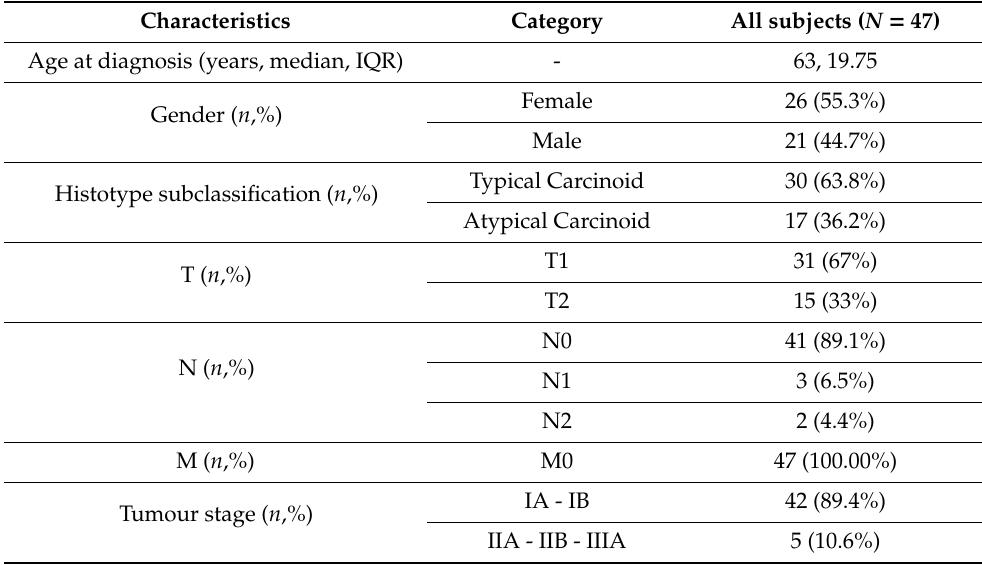
Table 2. Clinical and pathological data of lung carcinoid patients cohort.